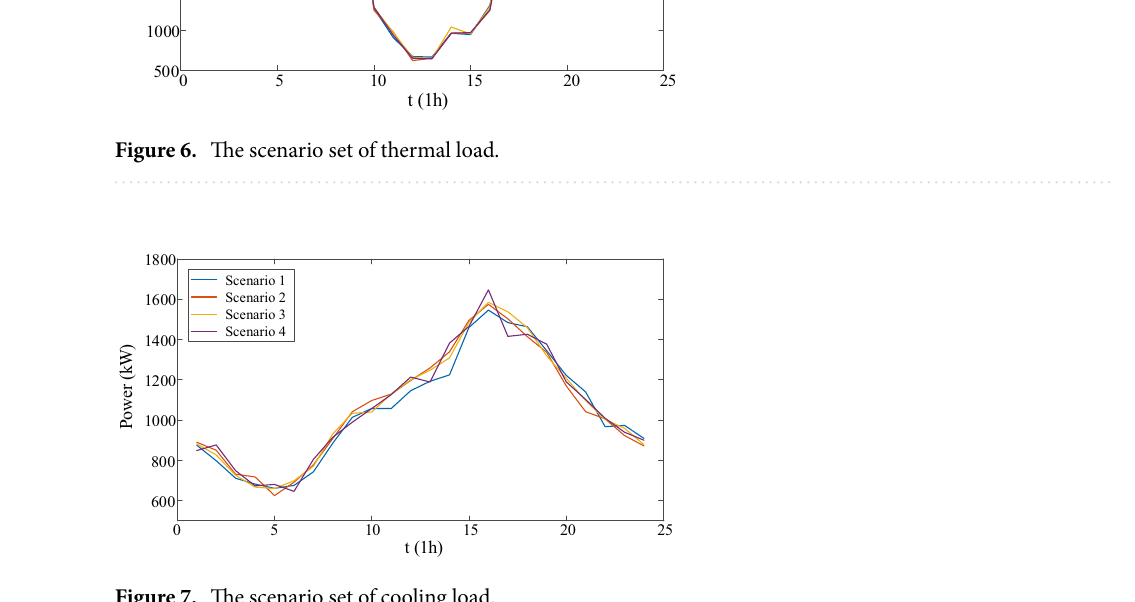
Figure 7. The scenario set of cooling load.